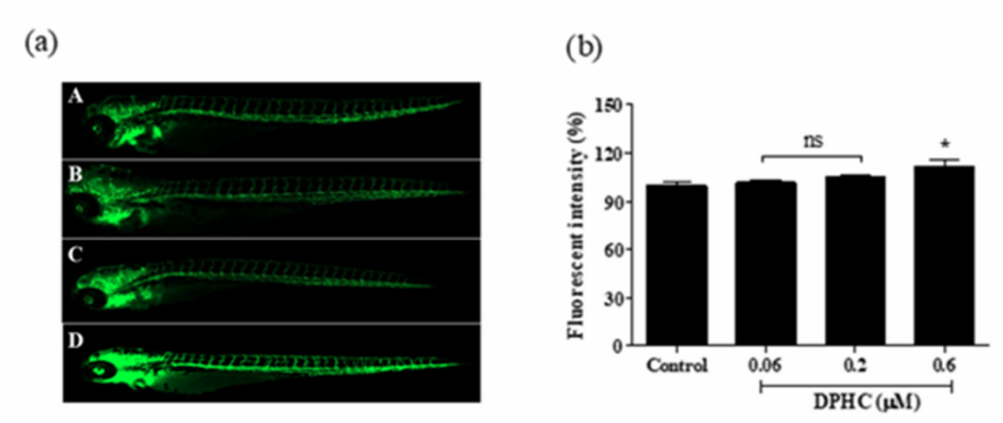
Figure 6. DPHC induces vasodilation in the whole-body vasculature in a Tg(flk:EGFP) transgenic zebrafish model. ( a ) Rep- resentative images of the Tg(flk:EGFP) transgenic zebrafish larva’s whole body captured using a fluorescence microscope (4 × ). A: 0 µ M of DPHC (Control); B: 0.06 µ M of DPHC; C: 0.2 µ M of DPHC; D: 0.6 µ M of DPHC. ( b ) Quantification of the whole-body fluorescence intensity. Each column and bar represent the mean ± standard deviation (S.D.), n = 8 per group. * p < 0.05, significant difference compared to the control group. ns: not significant; DPHC: diphlorethohydroxycarmalol.